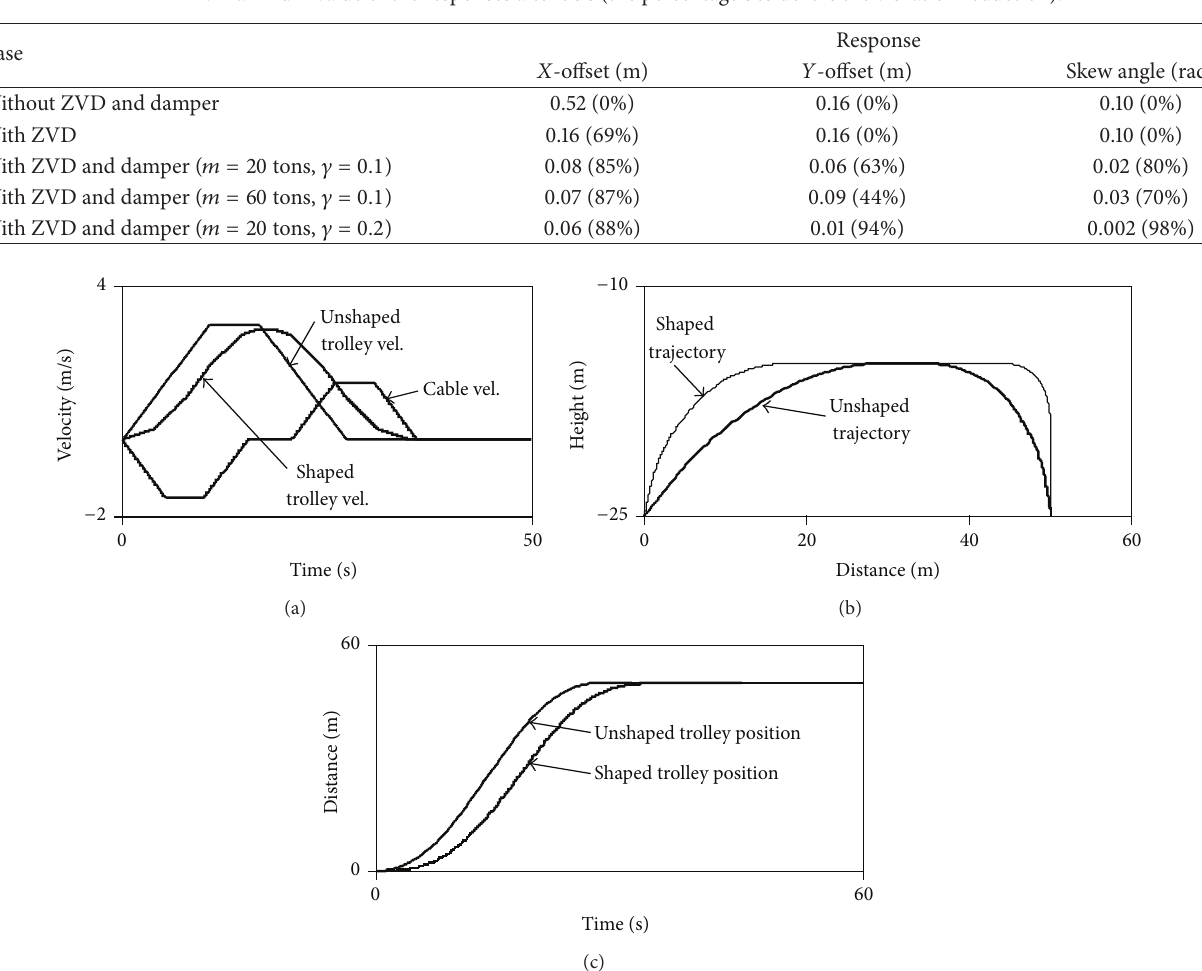
Table 2: Maximum value of the responses after 50s (the percentage beside it is the vibration reduction).